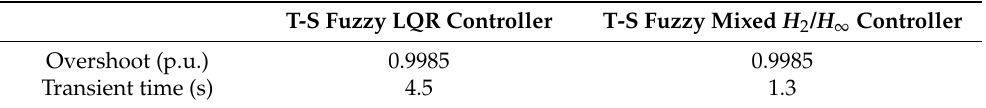
Figure 17. The curve of unbalanced power change during sudden 0.2 (p.u.) load increase. Table 5. Comparison of performance indicators of different controllers in Case